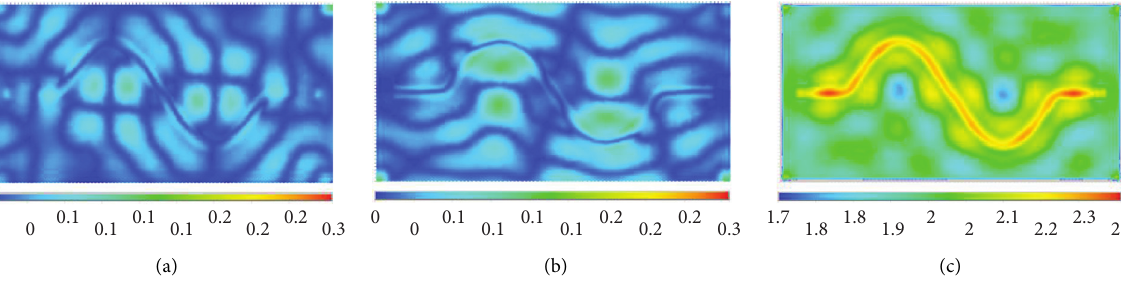
Figure 42: P wave incident ( C